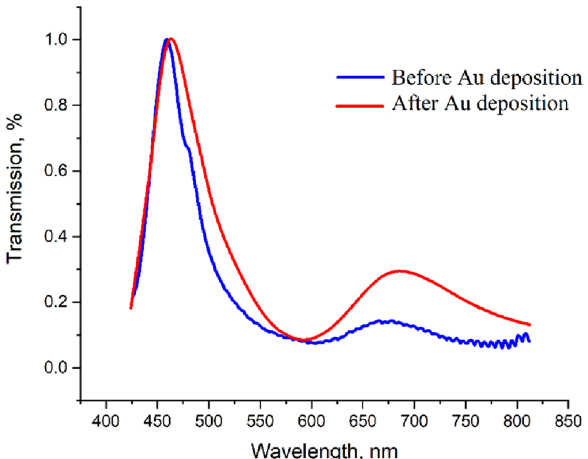
Figure 2. Normalised transmission spectra of a plasmonic device measured in air before and after capping with 10 nm of Au.